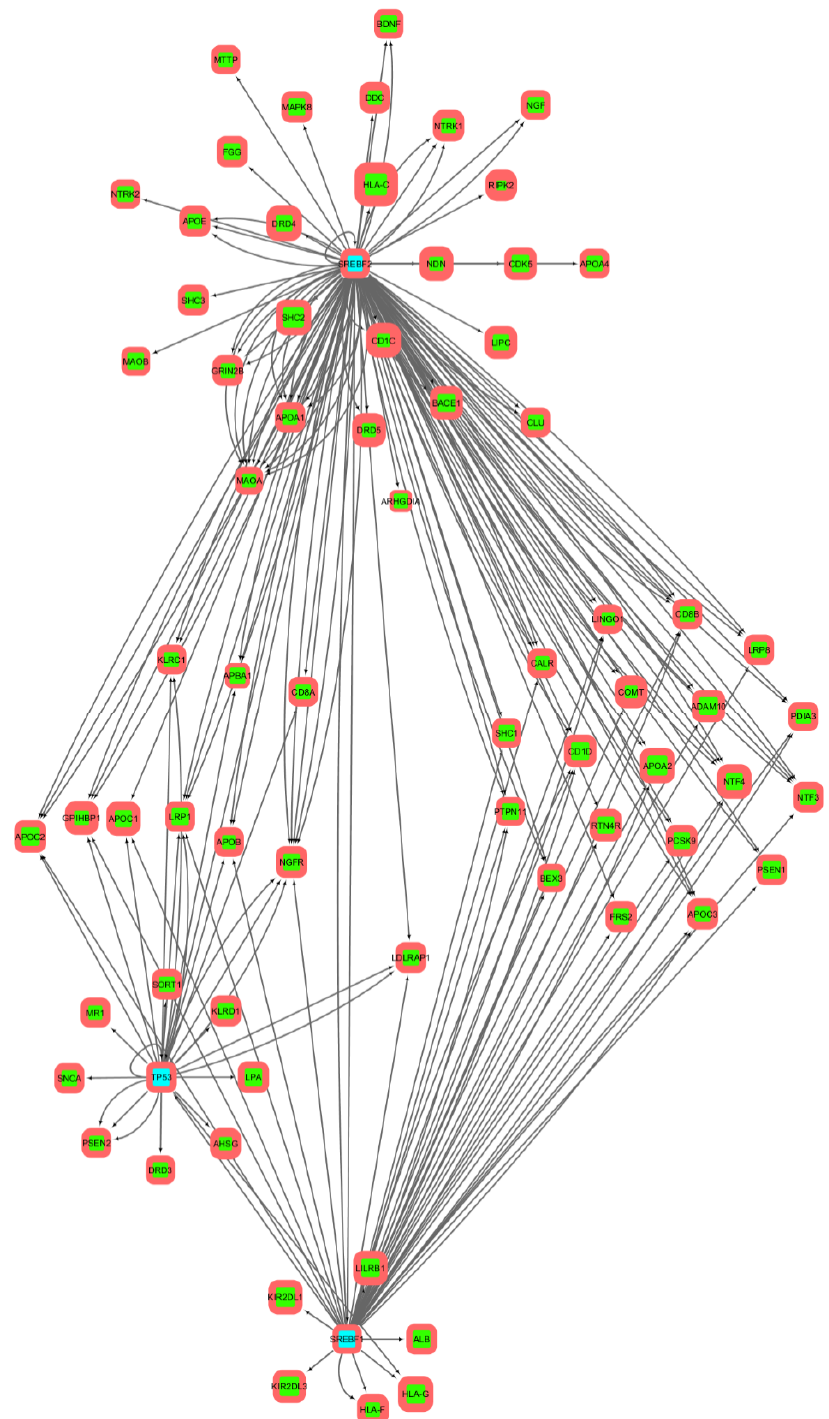
Figure 4. Transcriptional regulation network built on predictions of transcription factor binding sites in upstream promoter regions of 1000 b.p. length. Transcription factors are cyan highlighted, green are regulated genes. Direction of arrows denote regulators (from) and regulated genes (to). The thickness of the frame corresponds to the enrichment of SNP in the upstream promoter region of the gene, the size of the node—the enrichment of SNP in the coding region of the gene.